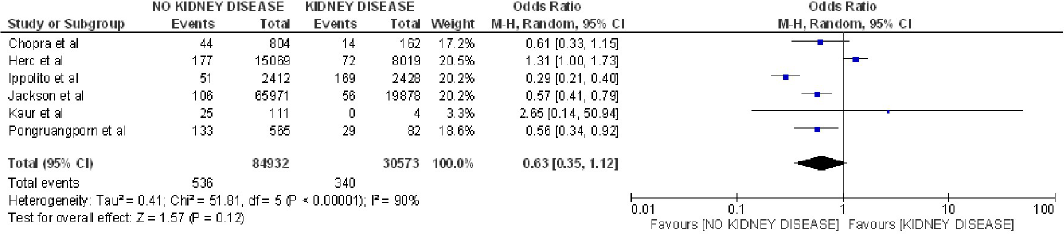
Fig 9. Forest plot of kidney disease and CLABSI.